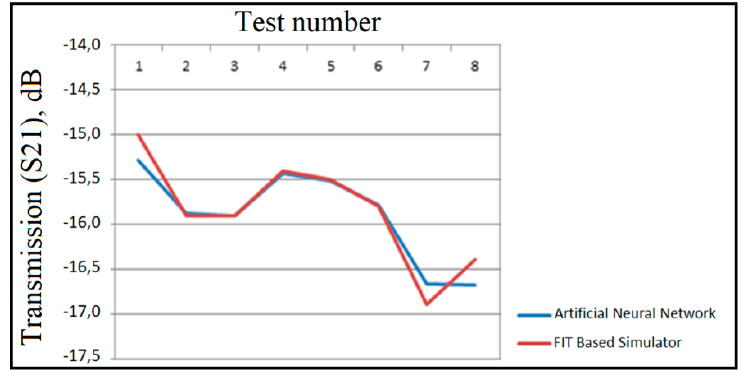
Figure 5. Comparison of an artificial neural network and Finite Integration Technique (FIT) based microwave simulator.